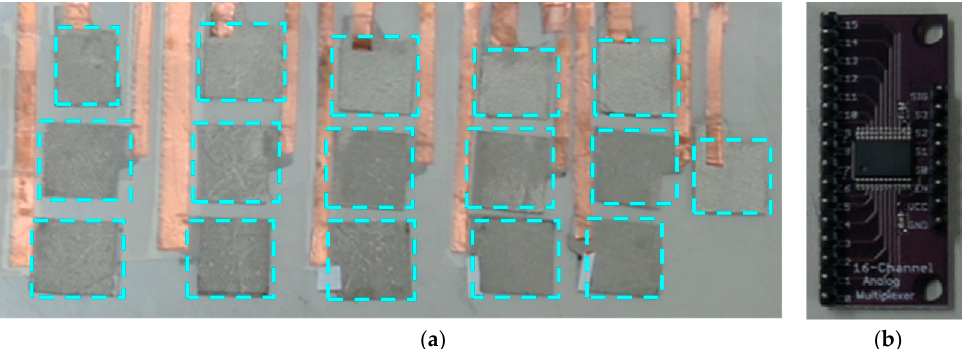
Figure 5. Bottom electrodes and multiplexer: ( a ) 3 × 5 + 1 bottom electrode array, dashed rectangle highlight the electrode patches ( b ) 16 ‐ channel multiplexing module.